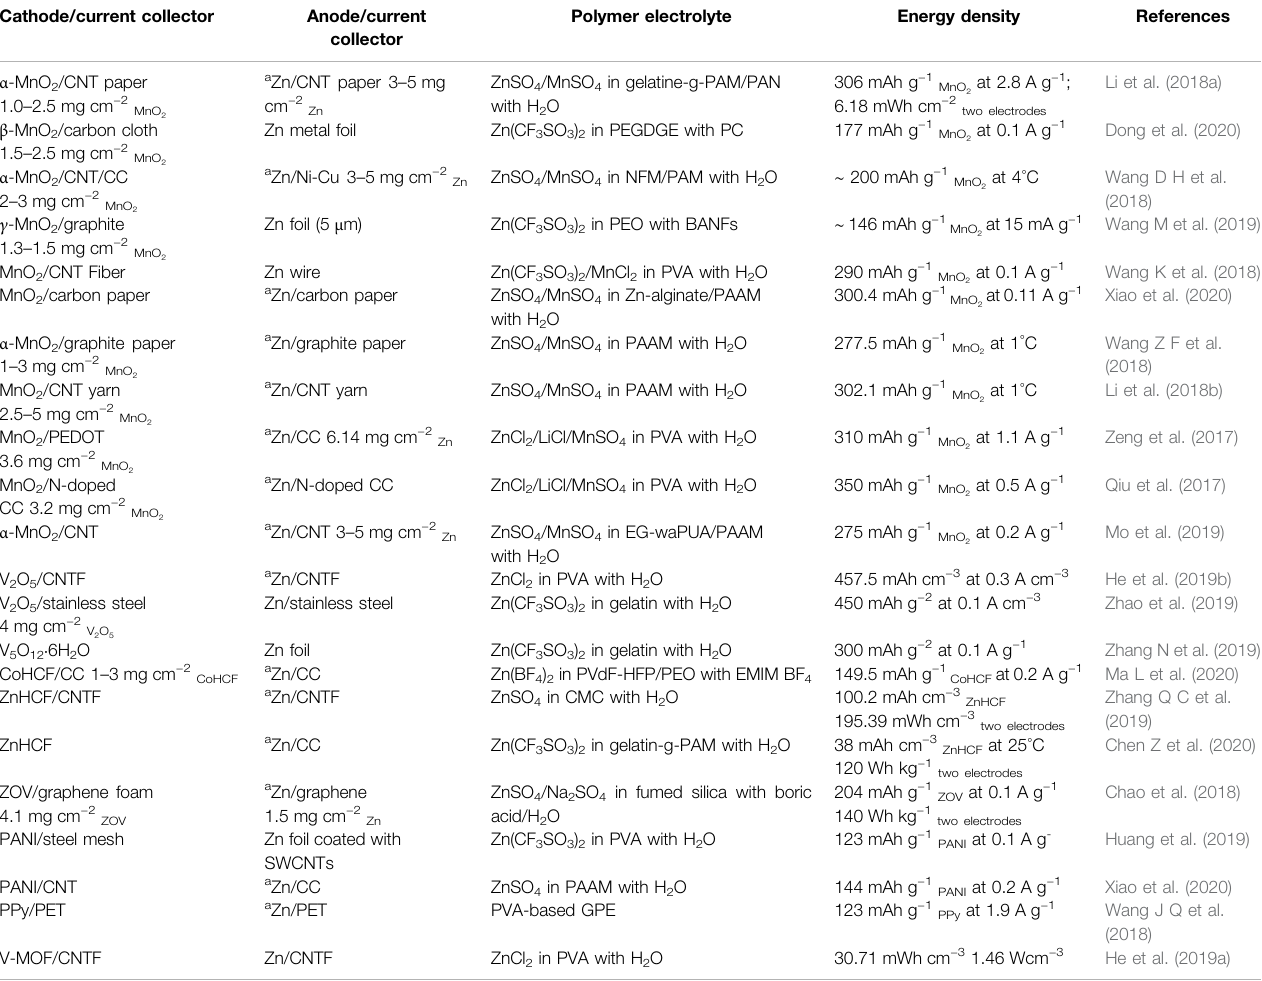
TABLE 1 | Summary of the key components and performance of solid-state zinc-ion batteries. Cathode/current collector Anode/current